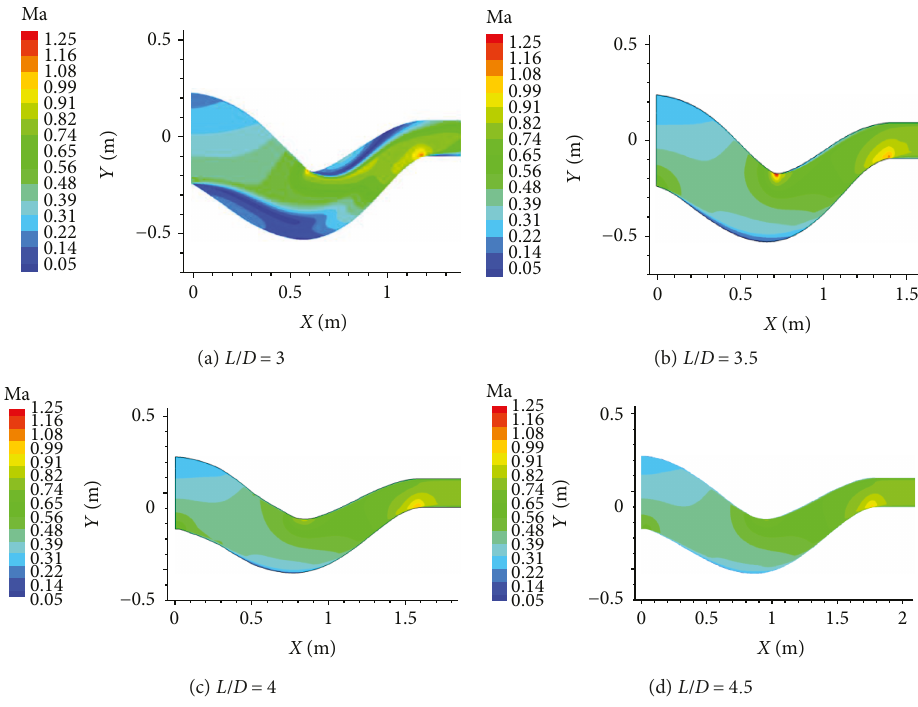
Figure 14: Mach number distributions on symmetric plane ( W / H = 3 3 , S / D = 0 ).